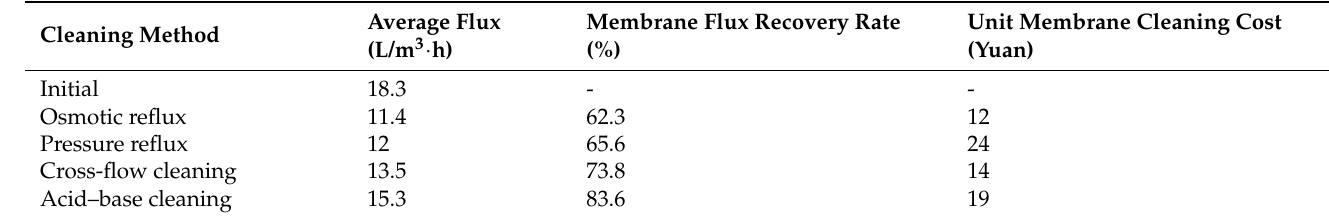
Table 5. Cost analysis of diverse cleaning method of FO